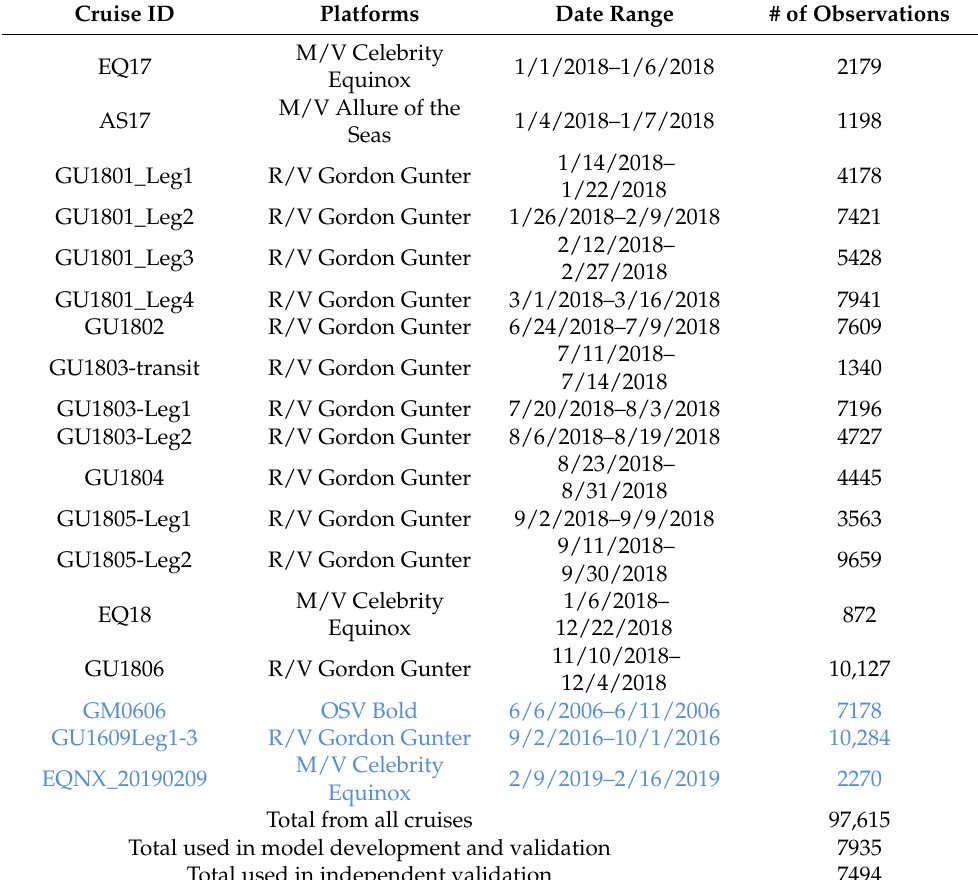
Table 1. Underway surface salinity measurements used for the development, validation and indepen- dent validation of the sea surface salinity(SSS) model. Independent validation cruises were listed in blue font. The cruise GU1609Leg1-3 Fall Pelagic Trawl/Acoustic Survey was listed as GU1609Leg1-3 for convenience. The number of total points used in model development and independent validation was the number obtained after conjugate matching. Cruise ID Platforms Date Range # of Observations M/V Celebrity EQ17